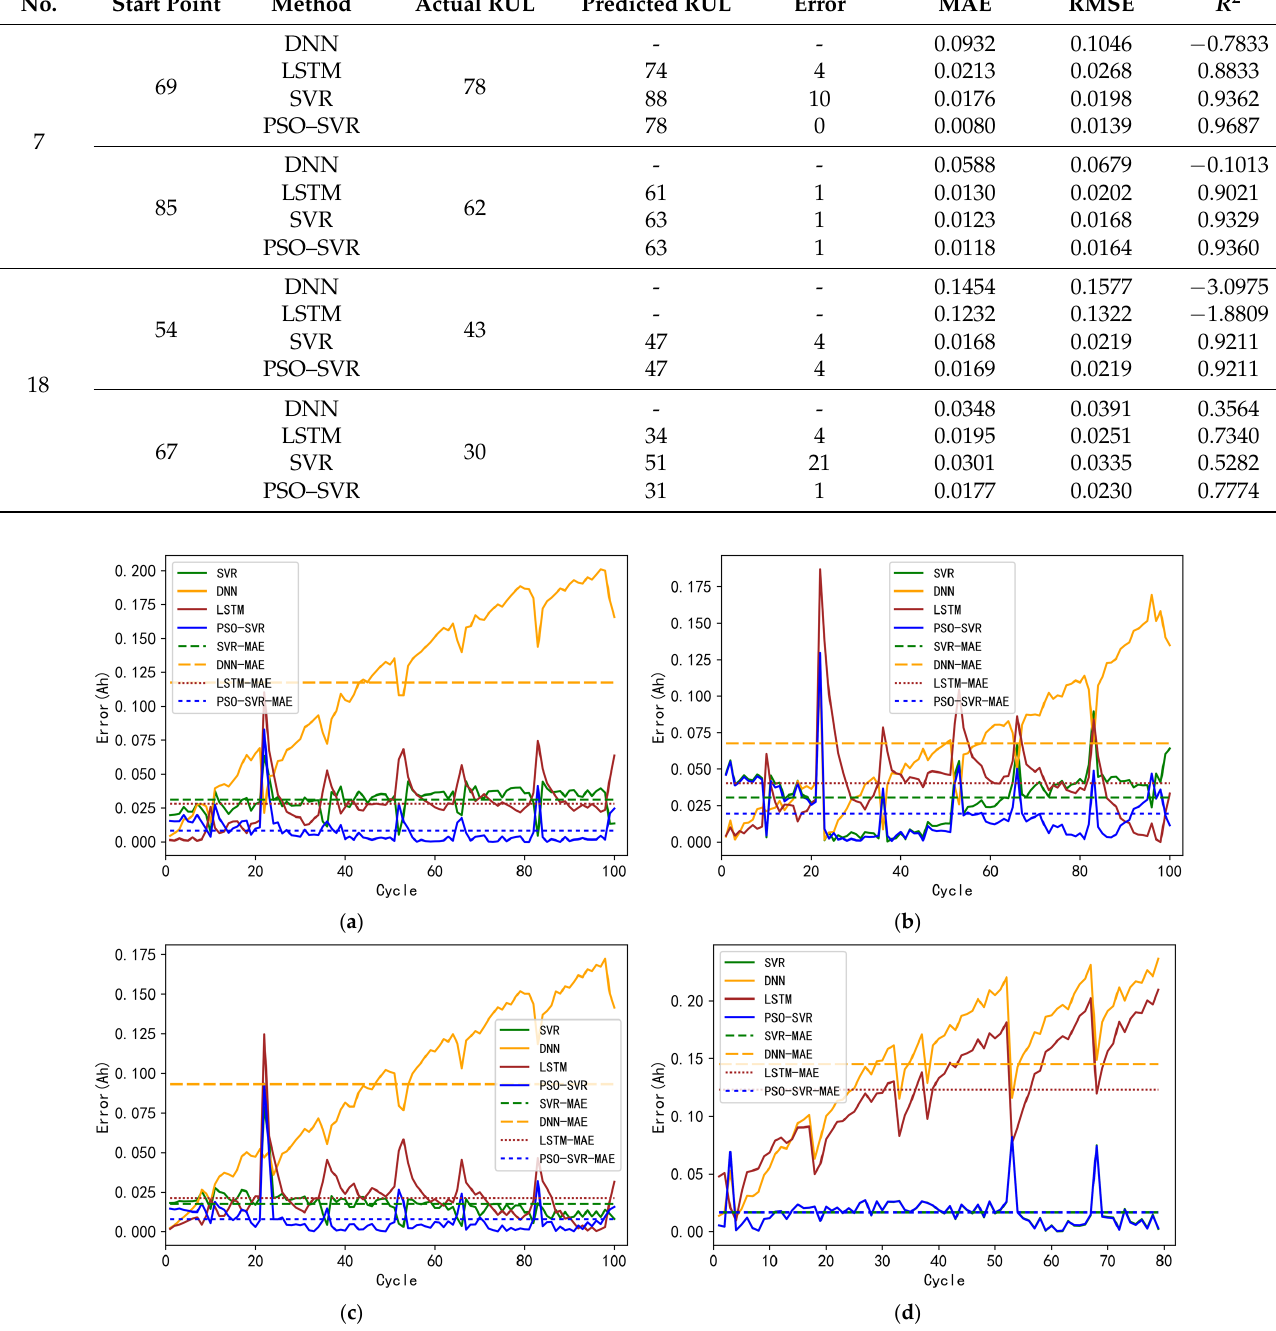
Figure 8. Absolute error and mean absolute error based on SVR, DNN, LSTM and PSO–SVR using the first 40% of the total cycle data for training: ( a ) B5; ( b ) B6; ( c ) B7; ( d ) B18.